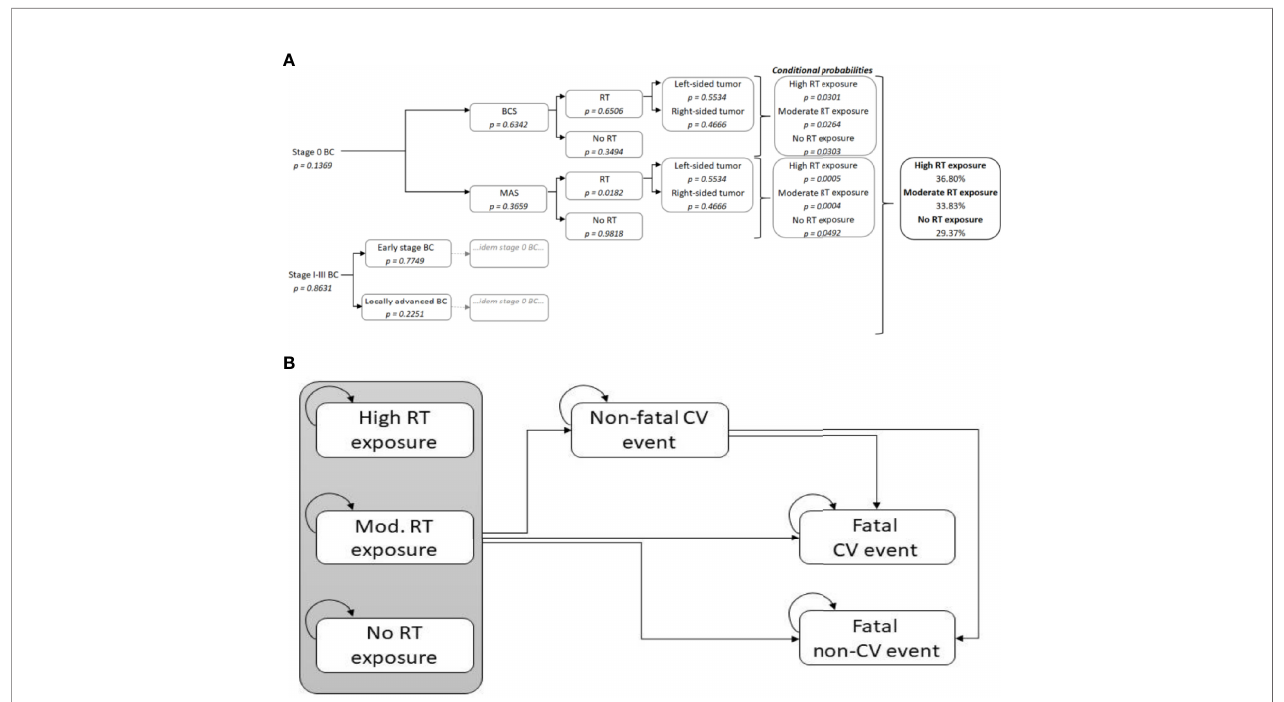
FIGURE 1 | (A) Decision tree. The branches represent different primary breast cancer treatment pathways. When radiotherapy is administrated, this results in a radiation dose to the heart according to the laterality of the tumour (for further details see Supplementary Material 1 ), (B) Markov model. The boxes represent the six health states of the Markov model. During each yearly cycle, patients may remain in the same state, or transition to another state (represented by the arrows in the fi gure). BC, Breast Cancer; BCS, Breast Conserving Surgery; CV, Cardiovascular; MAS, Mastectomy; RT,